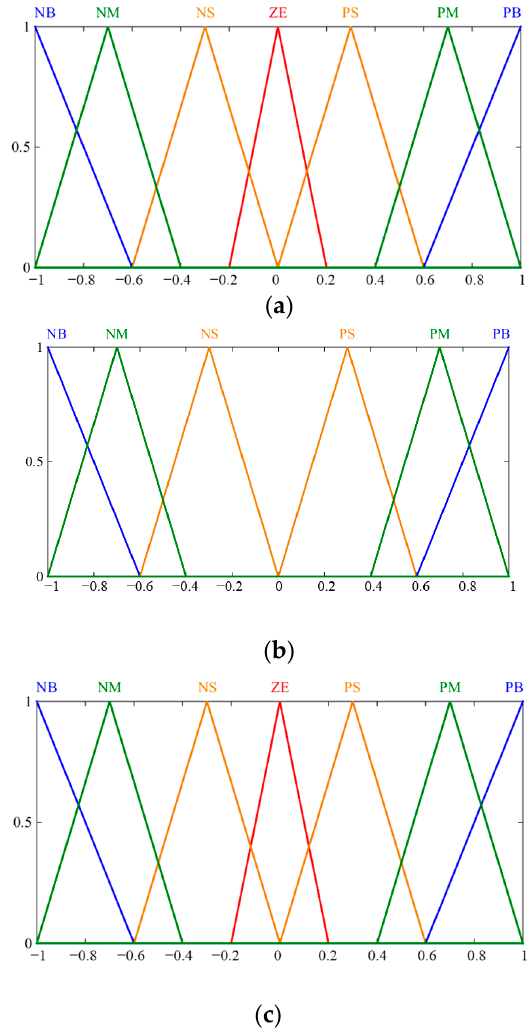
Figure 8. Membership degree curve: ( a ) Membership curve of E ; ( b ) Membership curve of EC ; ( c )